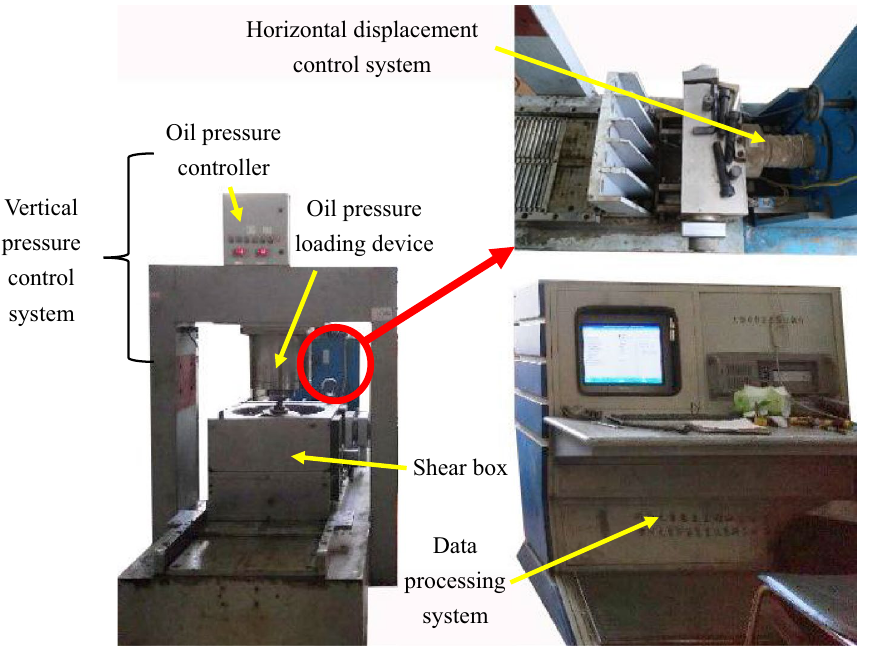
Figure 1. Photos of the large-scale direct shear